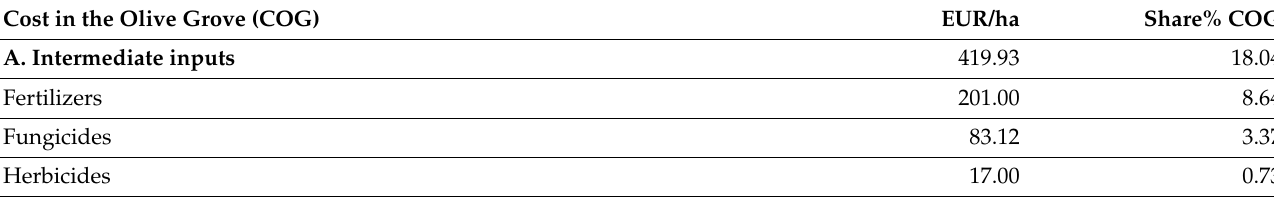
Table 3. Costs, agricultural income and feasibility analysis of olive production in Brazil, calculated in EUR/ha with full budgeting using the policy analysis matrix